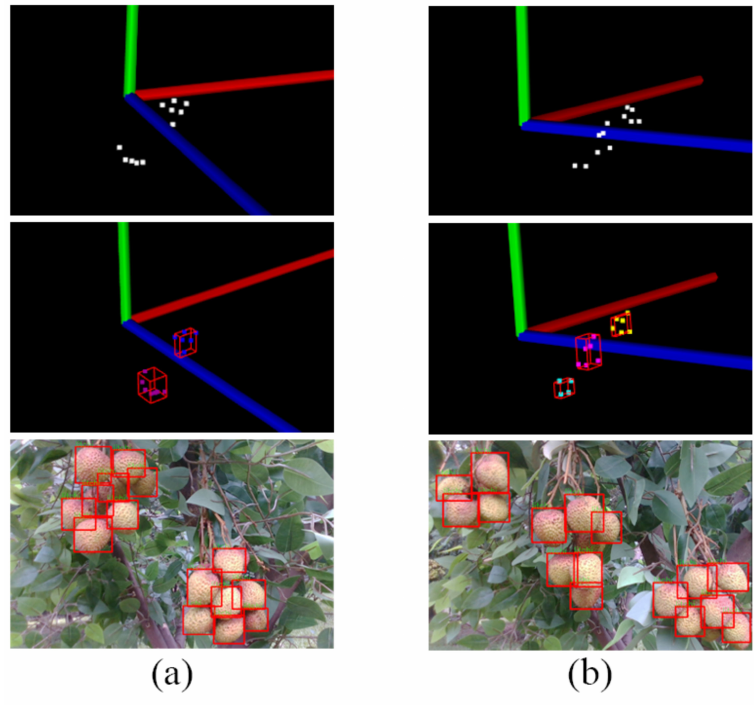
Figure 13. DBSCAN experiment: ( a ) two clusters; ( b ) three